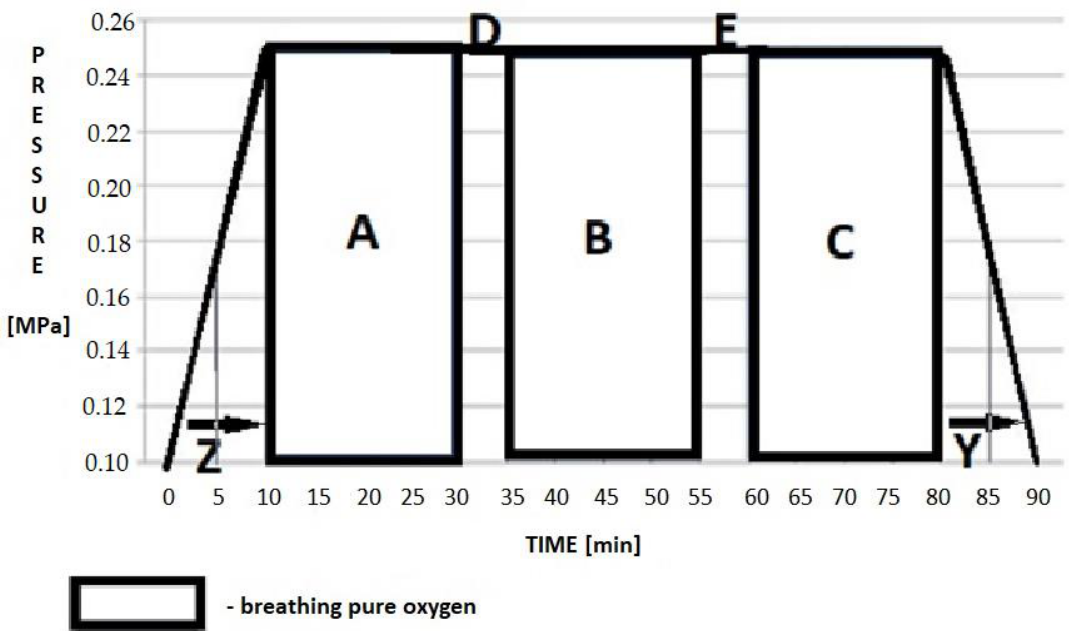
Figure 1. Treatment profile in a hyperbaric chamber: (A–C) time during which the patient was breathing pure oxygen under hyperbaric conditions with the use of a mask or helmet; (D,E) air brakes aimed at breathing air contained in a hyperbaric chamber without the use of individual oxygen devices. Z—time to full compression. Y—decompression time.